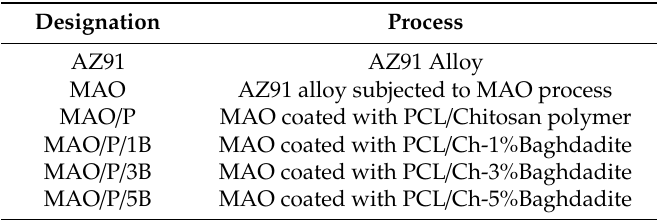
Table 1. The designation of various samples.